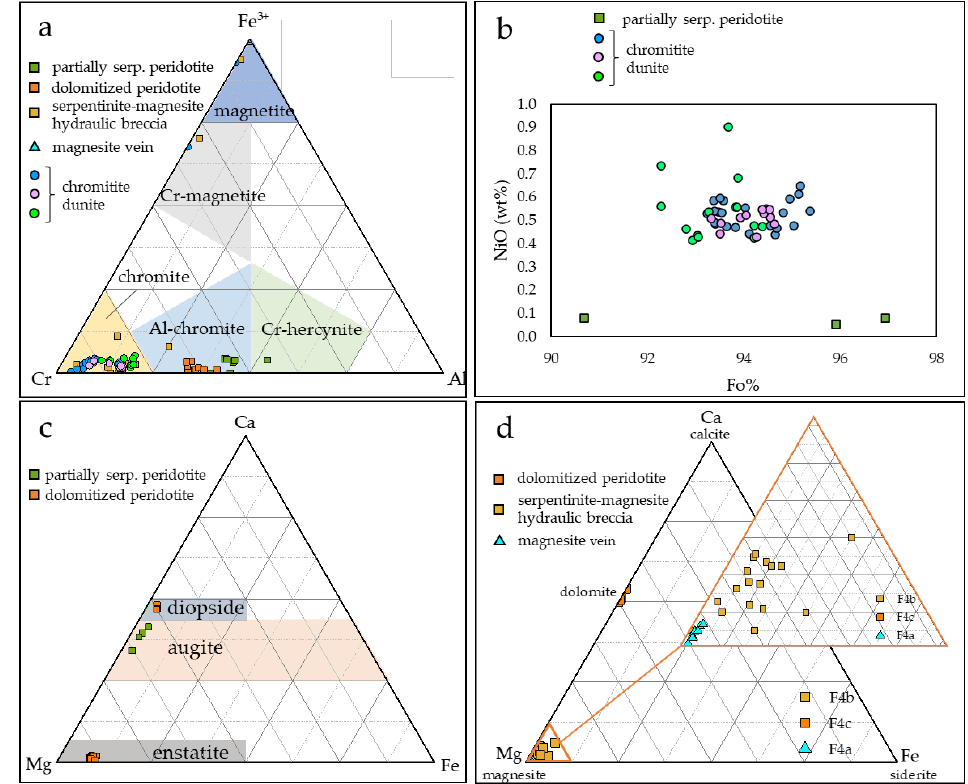
Figure 8. Ternary compositional diagrams of ( a ) spinels from chromitites and peridotites; composi- tional fields are from [24]; ( b ) olivine from chromitites and peridotites; ( c ) pyroxene from partially serpentinized peridotite and dolomitized peridotite; ( d ) carbonate phases from magnesite vein, ser- pentinite – magnesite hydraulic breccia and dolomitized peridotite. Table 1. Major and minor elements average composition and standard deviation of chromite cores from Kymasi lithologies; Mg# = [Mg/(Mg + Fe 2+ )]; Cr# = [Cr/(Cr + Al)]. Fe 2 O 3 and FeO are calculated based on stoichiometry.